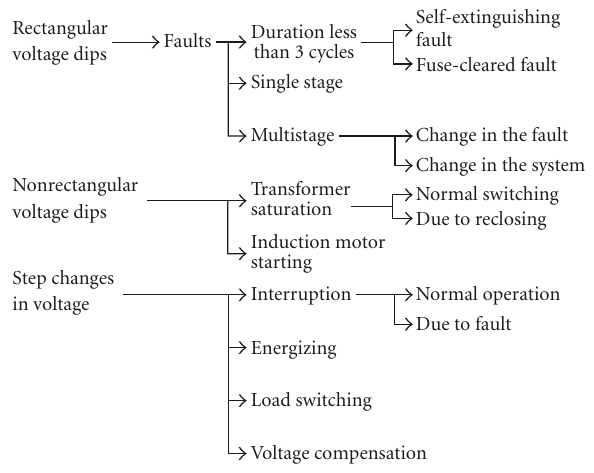
Figure 14: A tree structured inference process for classifying power system disturbance